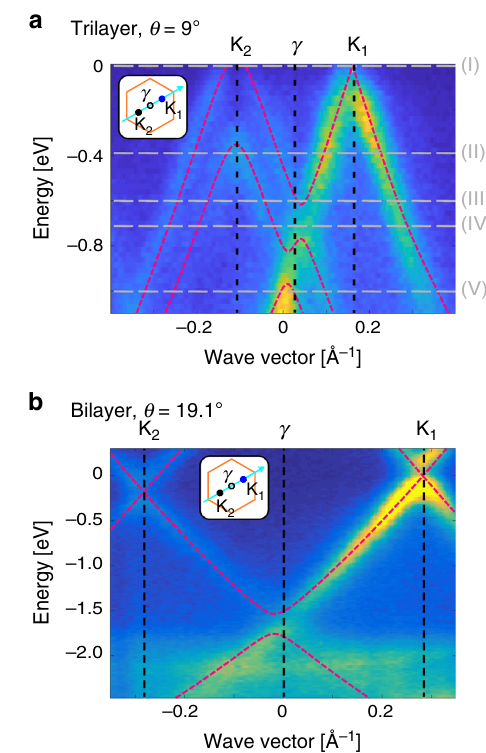
Fig. 3 Modelling stacks with different twists and layer numbers. Comparison of the ARPES intensity and the calculated electronic band structure (obtained using the parameter set in Table 1 and shown with red dashed lines) for a twisted trilayer with θ = 9 ∘ and b twisted bilayer with θ = 19.1 ∘ , both measured along the direction connecting Brillouin zone corners K 2 and K 1 as shown in Fig. 1c and indicated in the inset. In a , the grey dashed lines, labelled (I)-(V), indicate energies for which constant- energy ARPES intensity maps are presented in Fig.